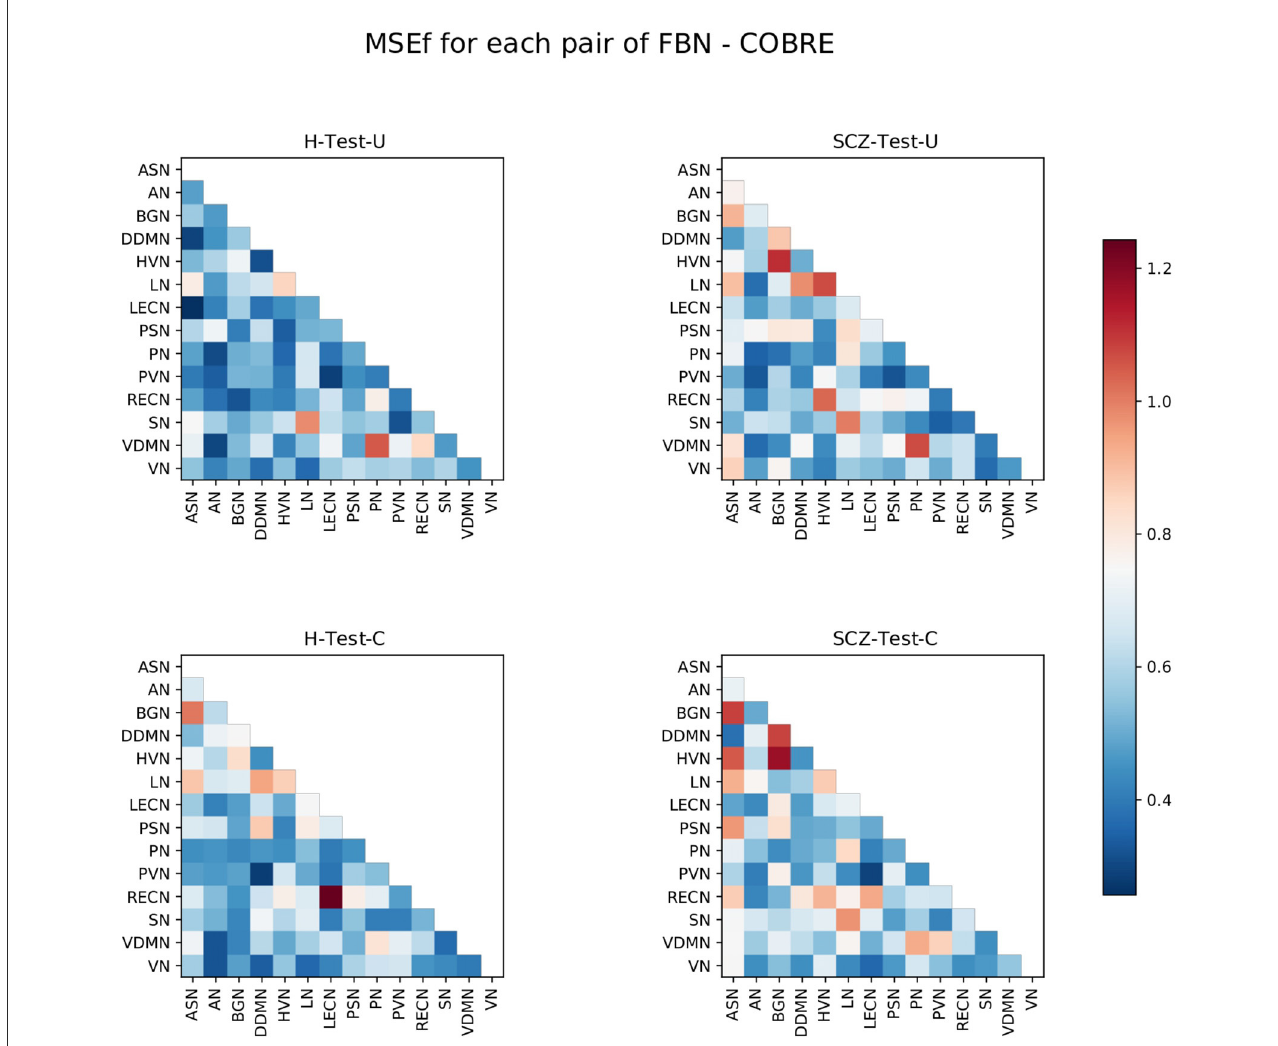
FIGURE9 Matrices representing the MSE f for each pair of FBNs, for the healthy (Left) and SCZ (Right) test sets of the UCLA (Top) and COBRE (Bottom) datasets. The color bar ranges between the same values of Figure